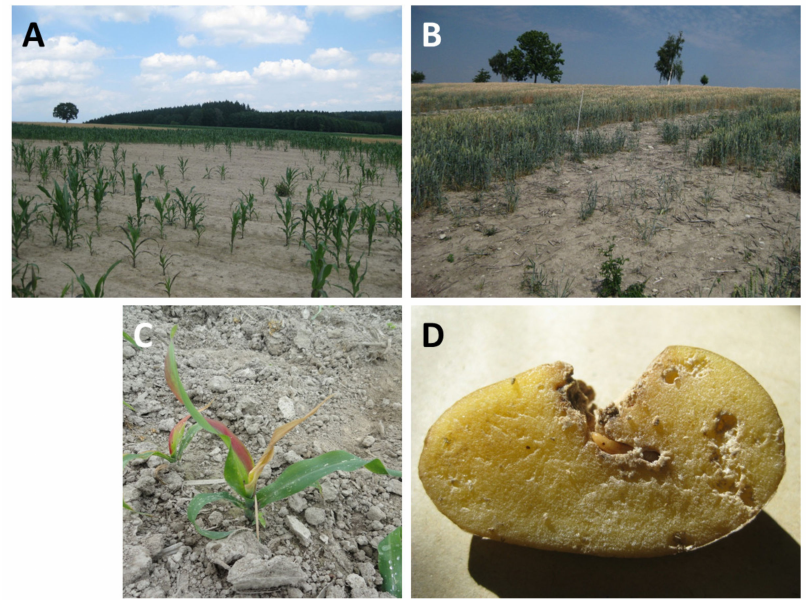
Figure 5. Illustration of crop damage and symptoms. ( A ) Damage in maize caused by mixed populations of A. obscurus and A. lineatus . ( B ) Damage in winter wheat caused by A. sputator . ( C ) Symptoms of wilting on maize small plants. ( D ) Damage on potato caused by A. obscurus . Photographs A, B, and D: JKI. Photogaph C: